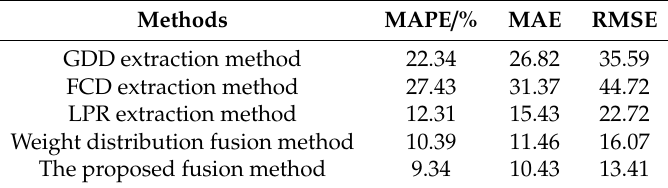
Table 2. Error analysis of average link travel time based on multi-sensor traffic data.